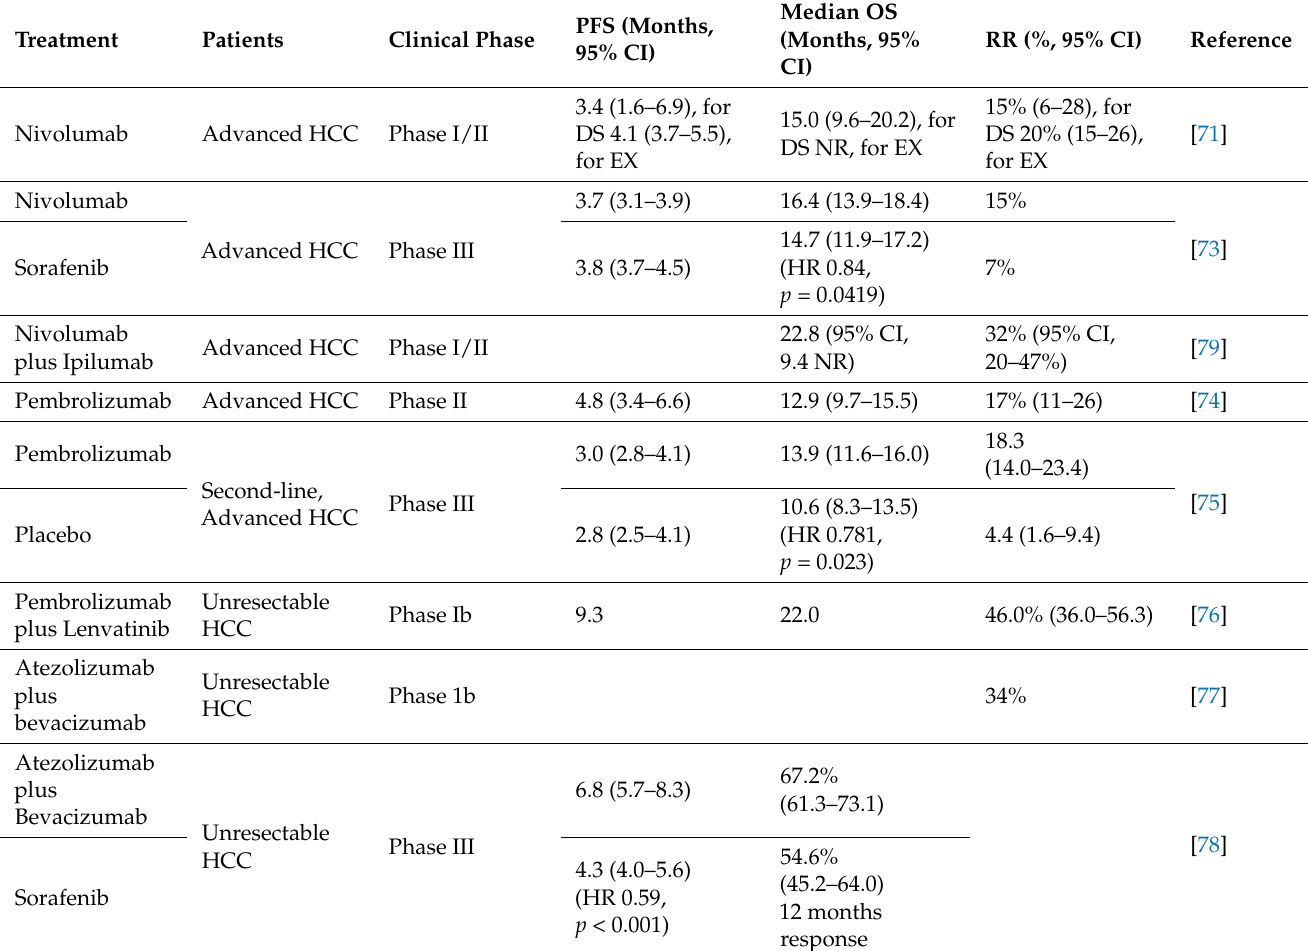
Table 2. Trials involving immune checkpoint inhibitors for the treatment of